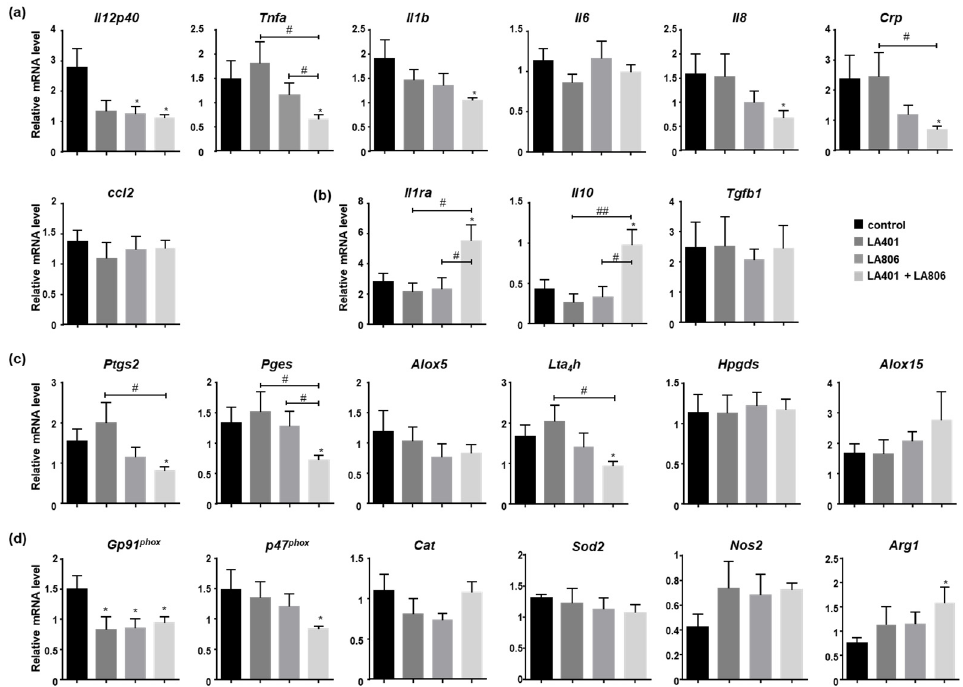
Figure 3. Influence of Lactobacillus helveticus LA401 and/or Lactobacillus gasseri LA806 oral administration on the colonic inflammatory and oxidative status of C. albicans -infected mice. LA401, LA806 alone or in combination were orally administered to mice for 12 days. After this treatment, mice were orally infected with Candida albicans . Mice were sacrificed 5 days later and total RNAs isolated from the colon were subjected to the RT-PCR analysis using specific primer sets for ( a ) pro-inflammatory cytokines and chemokines ( Il12p40 , Tnfa , Il1b , Il6 , Il8 , Crp , Ccl2 ), ( b ) for anti-inflammatory cytokines ( Il1ra , Il10 , Tgfb1 ), ( c ) for enzymes involved in the production of pro- or anti-inflammatory eicosanoids ( Ptgs2 , Pges , Alox5 , Lta 4 h , Hpgds , Alox15 ) and ( d ) for enzymes involved in oxidative stress ( Gp91 phox , p47 phox , Cat , Sod2 , Nos2 , Arg1). Primers are listed in Table 2. n = 10 per experimental group. Data are presented as means ± SEM. * p ≤ 0.05 compared to control. # p ≤ 0.05, ## p ≤ 0.01 compared to treatments.